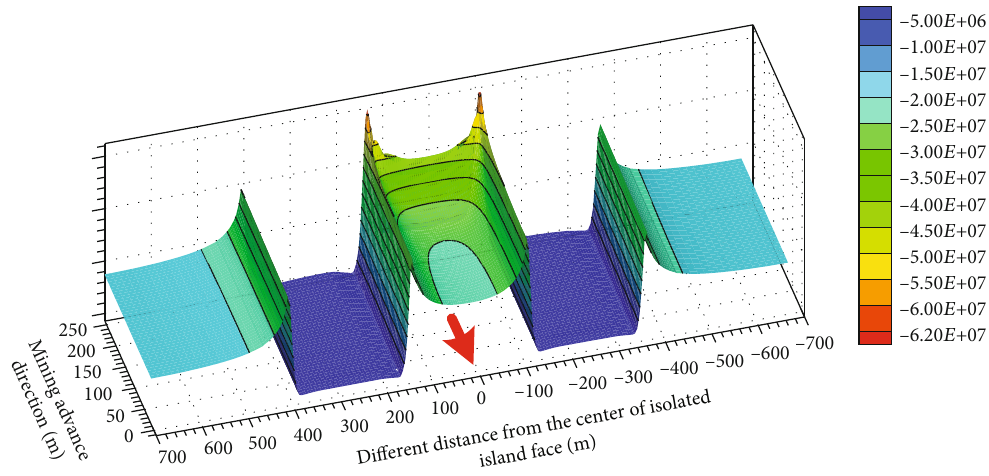
Figure 4: Distribution characteristics of advance mining stress in the isolated island